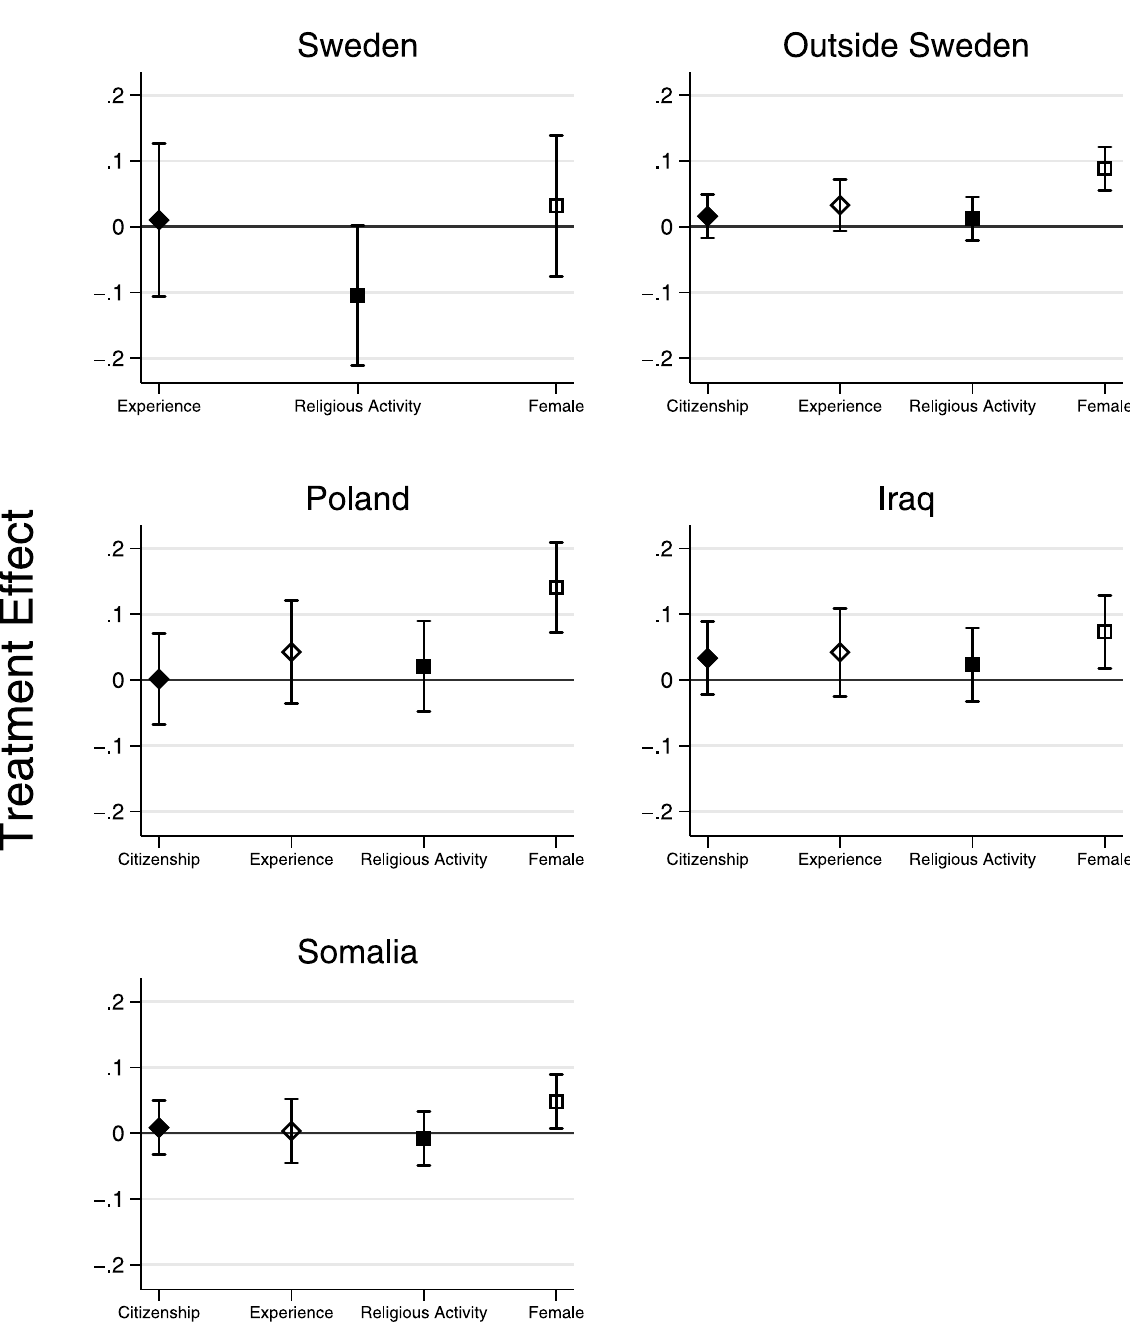
Fig 3. Impact of treatments on callback rates by country of birth. Note: Capped bars represent 95% confidence